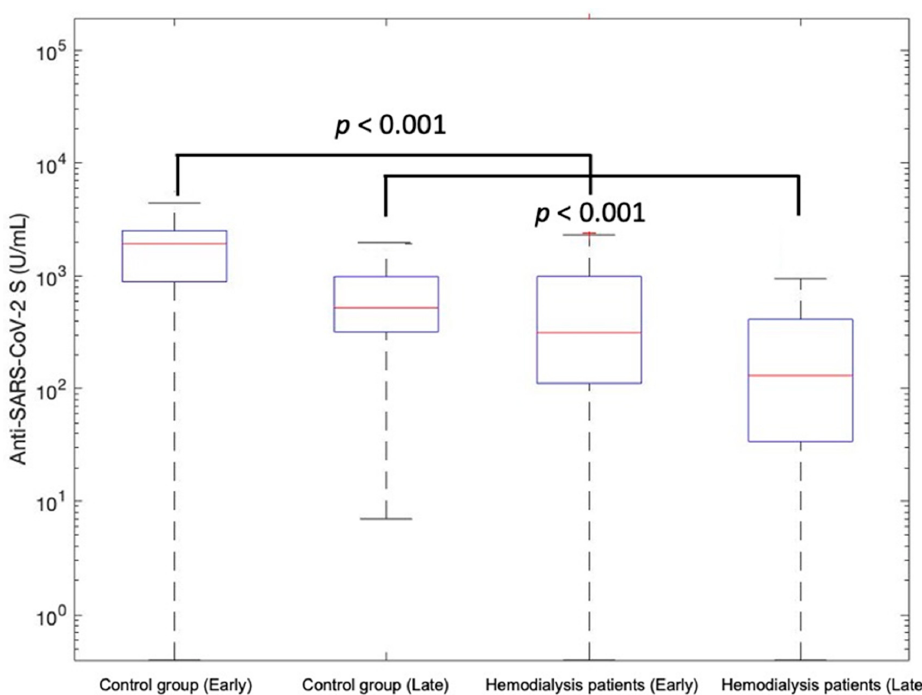
Figure 1. Early and late Anti-SARS-CoV-2 S antibody response in individuals after COVID-19 vaccination. Anti-SARS-CoV-2 S antibody titers are shown in uninfected hemodialysis patients and controls. The box shows the interquartile range, the horizontal line inside the box represents the median values, and whiskers represent the minimum and maximum range of points within 1.5 times the interquartile range in the box.